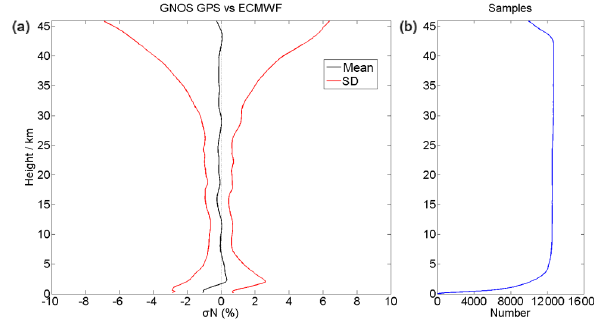
Figure 5. Comparisons of GNOS GPS, COSMIC, and MetOp/GRAS in terms of raw bending angles (from 1 November to 31 December 2013). In (a) , the solid curves show the mean biases for the two collocation ensembles, and the dashed curves show the standard deviations. (b) shows the collocation ensemble size, increasing with altitude since less collocated profiles reach into the lower troposphere (source: Liao et al., 2016b).